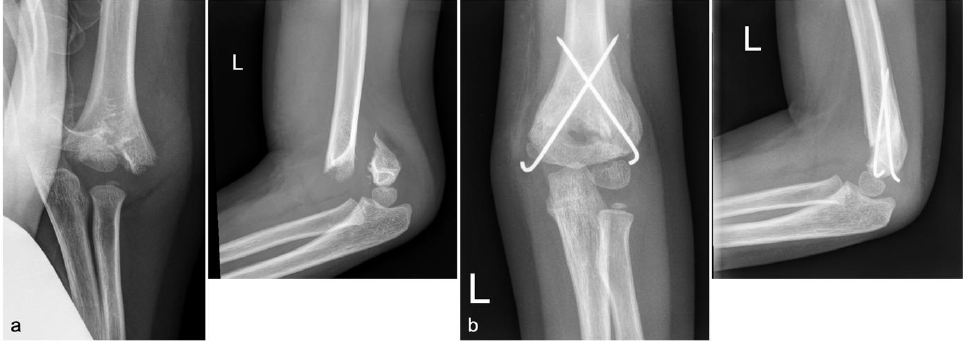
Figure 3. The course of a surgically treated type IV supracondylar fracture of the left (L) arm of a 6-year-old boy who fell from a climbing frame (1.5 m). ( a ) Initial a.p. and lateral X-rays showing the type IV fracture according to the Von Laer classification. The boy was operated on the same day. ( b ) A.p. and lateral X-rays after bilateral K-wire fixation 6 weeks postoperatively with new bone formation. Implant removal was performed 7 weeks after the initial surgery. The patient had no